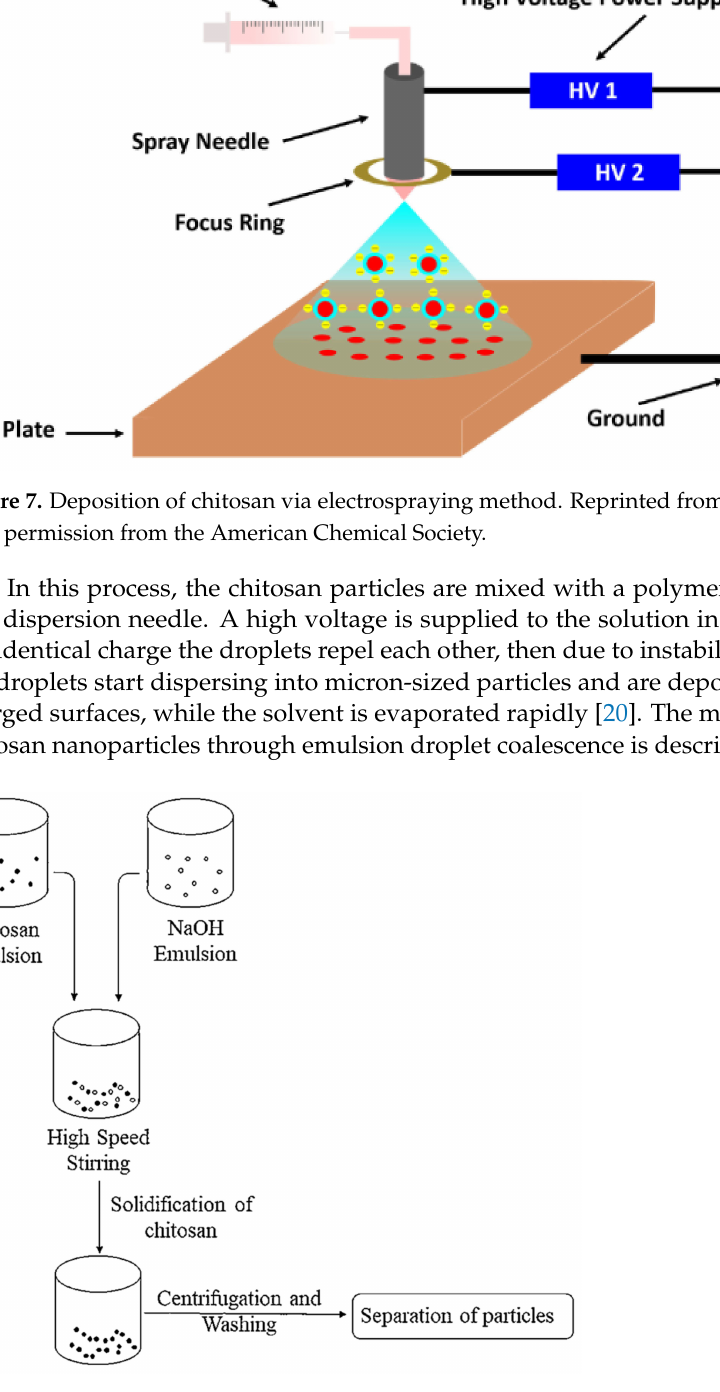
Figure 8. Emulsion droplet coalescence method used to produce chitosan nanoparticles